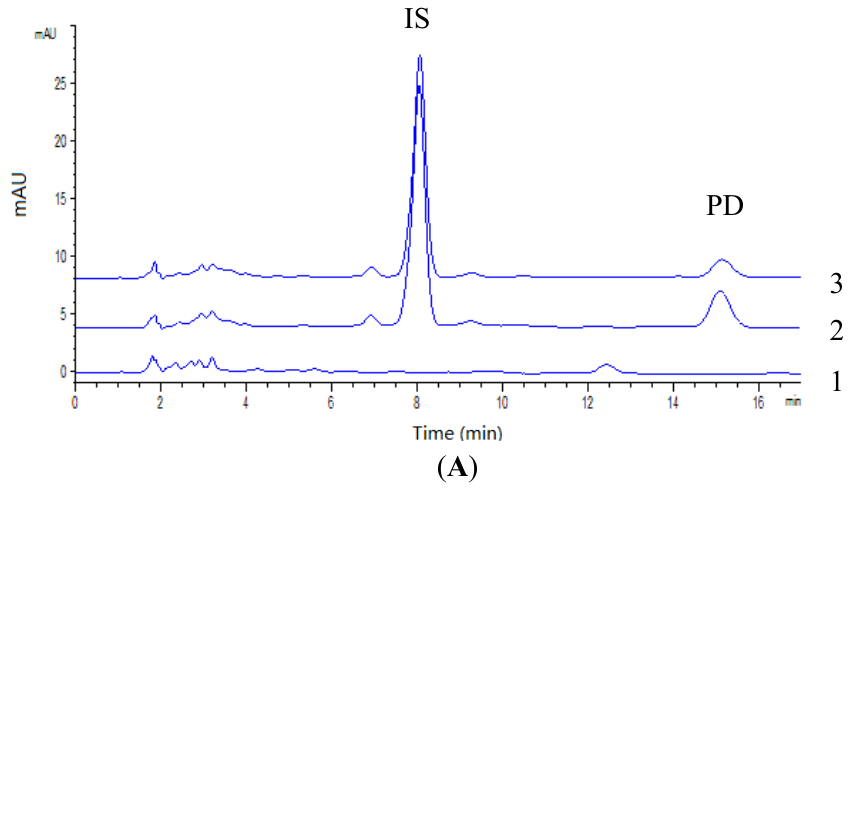
Figure 2. Representative chromatograms of plasma ( A ), liver ( B ) and lung ( C ). 1. blank plasma or tissues (liver and lung); 2. blank plasma or tissues (liver and lung) spiked with PD and IS; 3. plasma or tissues (liver and lung) sample at 60 min following i.v. administration of PD at a single dose of 10